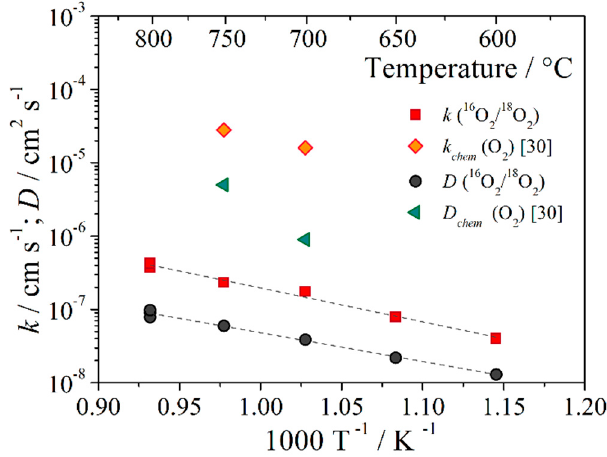
Figure 3. Temperature dependence of oxygen surface exchange and diffusion coefficients for oxide Sr 2 Fe 1.5 Mo 0.5 O 6 −δ